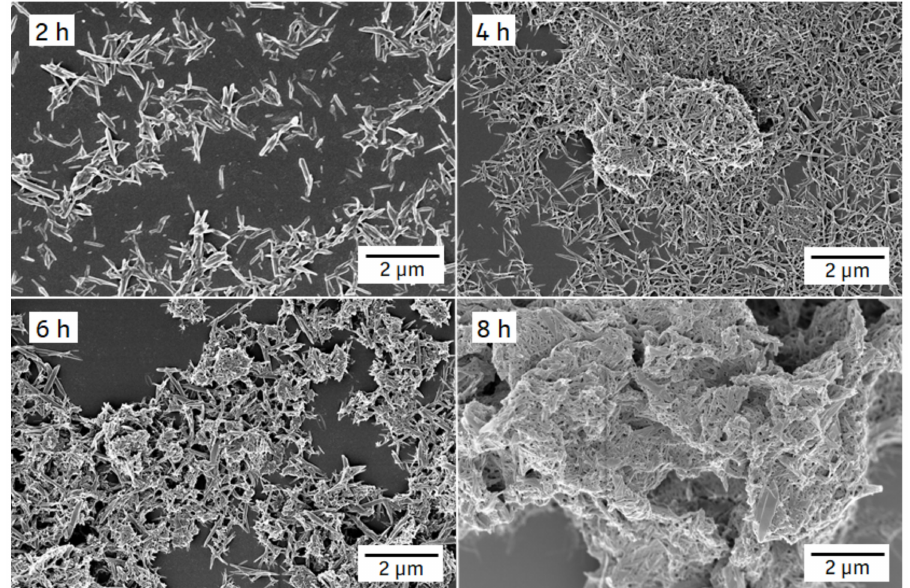
Figure 8. SEM images of F2 ITZ nanosuspension after different milling periods (indicated in the left upper corner of each image). Milling was carried out at 4 ◦ C with 1500 rpm and milling beads sized 0.3–0.4